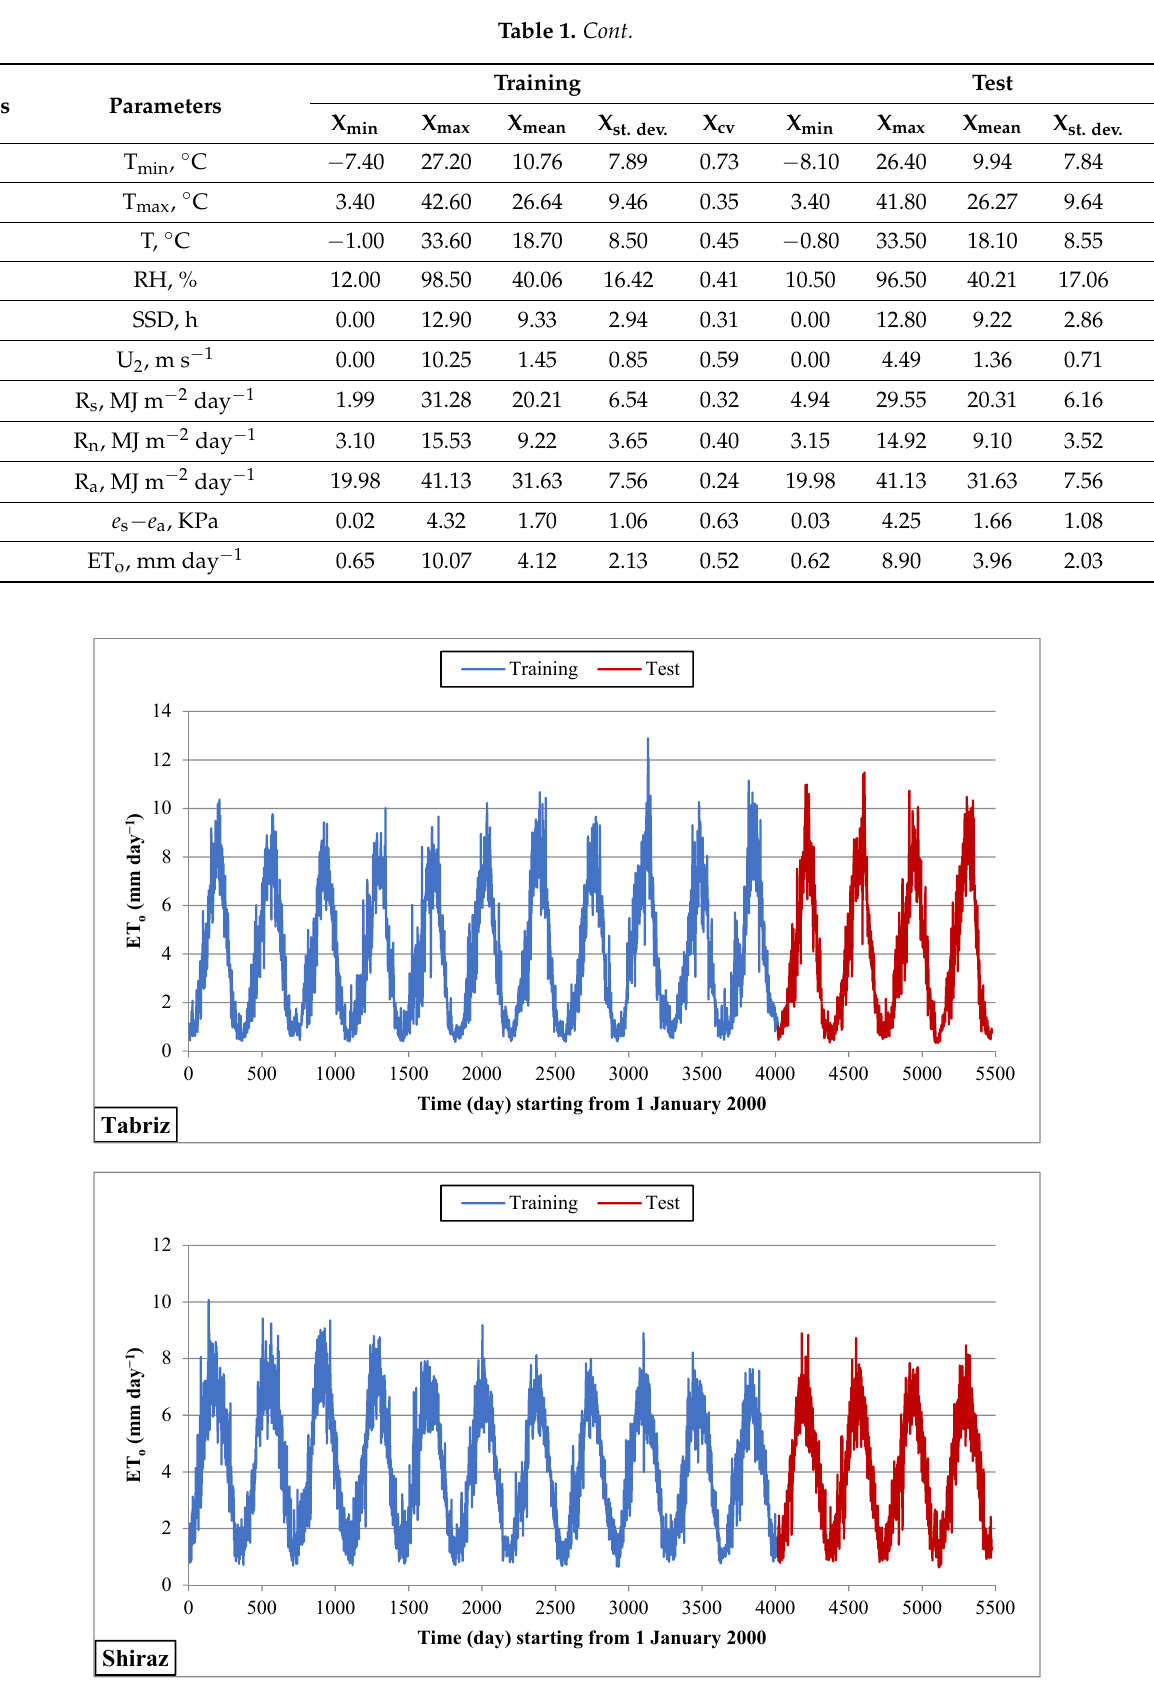
Figure 2. Time series of daily ETo estimated with FAO-56 PM method at the two studied sites during 2000–2014. Table 1. Statistical characteristics of the data used in this study.